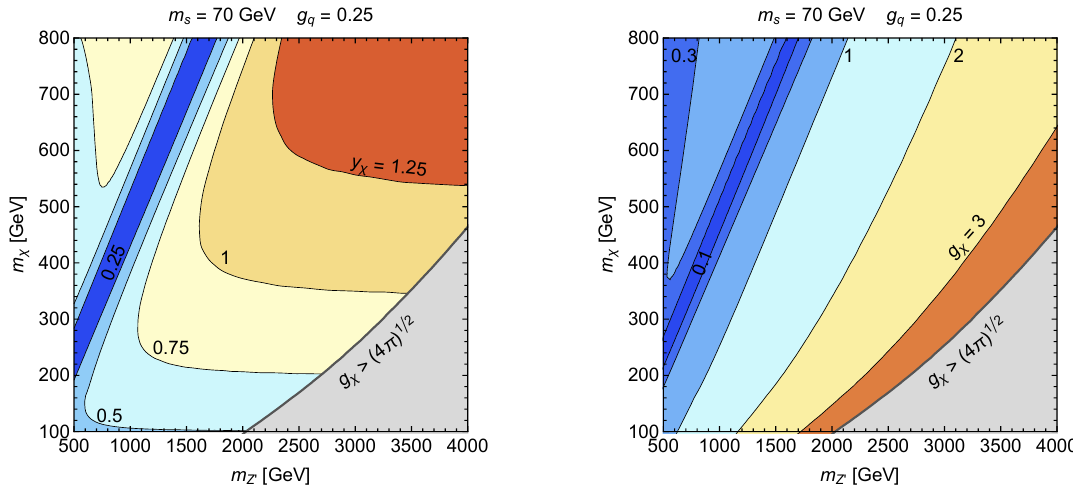
Figure 6 . Value of y (cid:31) (left) and g (cid:31) (right) in the m (cid:31) - m Z 0 plane determined by the relic abundance requirement for m s = 70 GeV and g q = 0 :